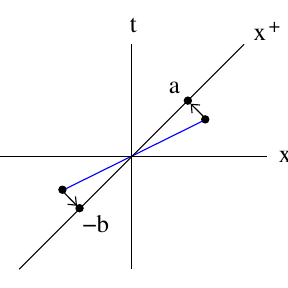
Figure 1 . The perturbation acts on the spacelike segment shown in blue. As θ → 0 + the segment approaches a piece of the x +